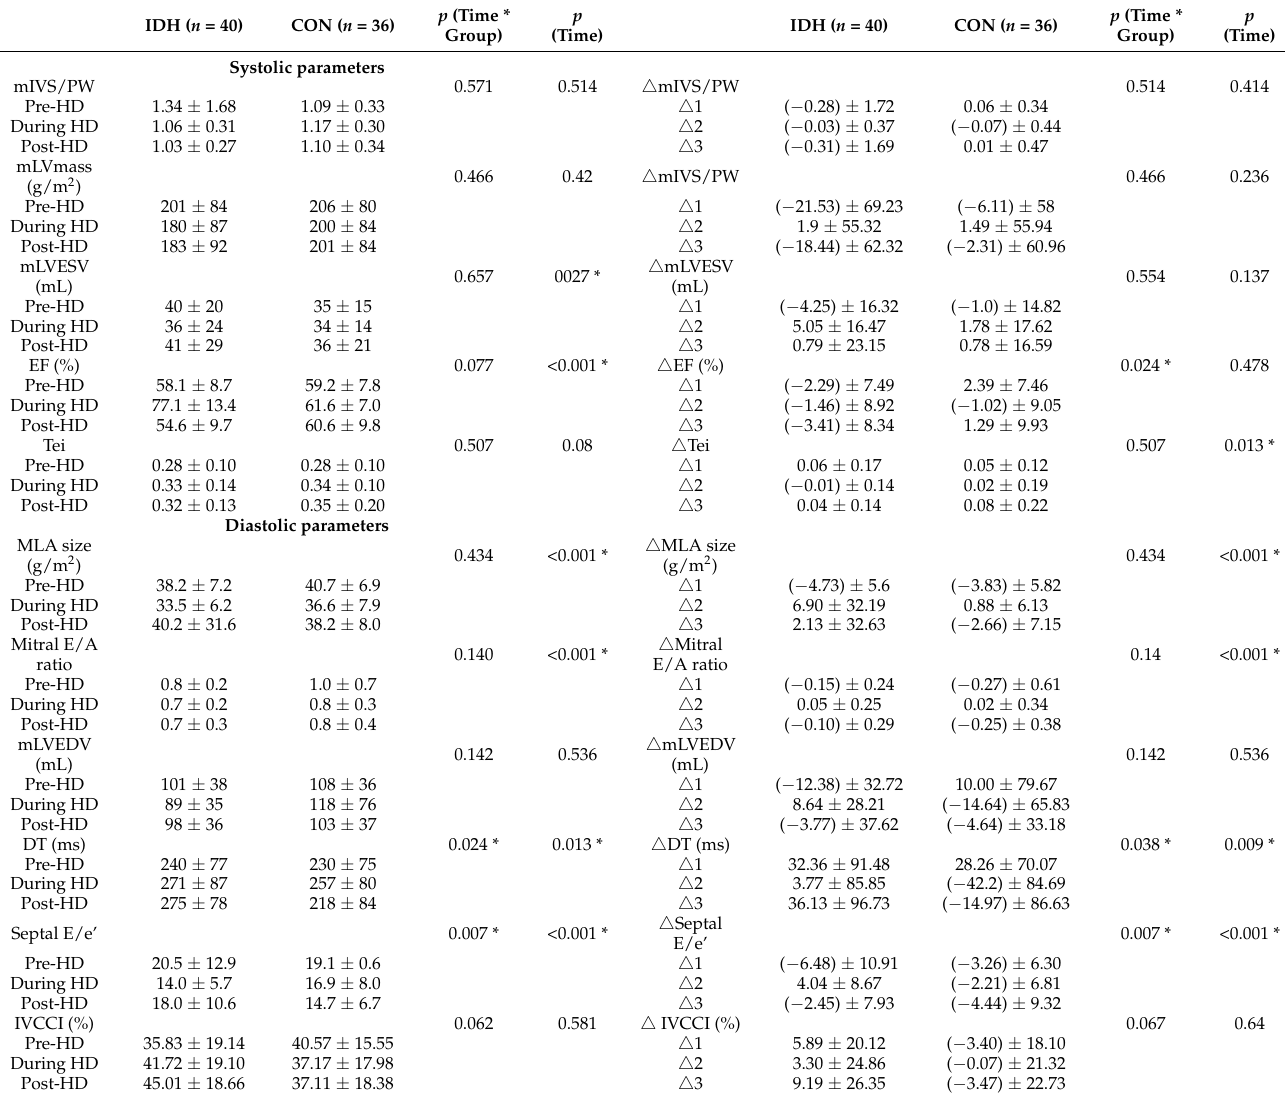
Table 3. Echocardiographic parameters during hemodialysis session between two groups explored by two-way repeated measures ANOVA